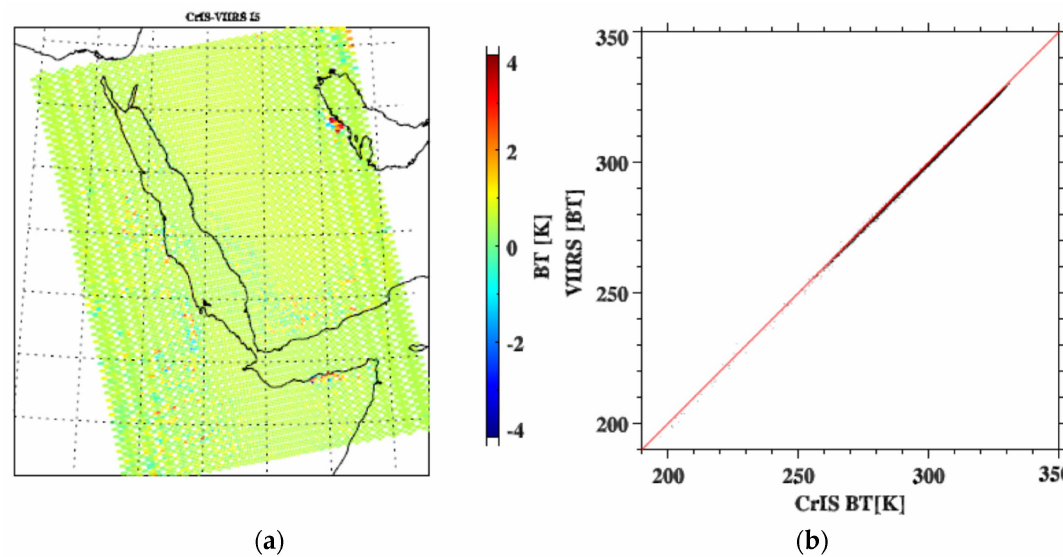
Figure 8. CrIS-VIIRS BT difference image map ( a ) and scatter plot of VIIRS BT versus CrIS BT for VIIRS I5 band ( b ). CrIS spectra are convolved with VIIRS SFRs to simulate VIIRS I5 band radiances, while collocated VIIRS radiances are spatially averaged within CrIS FOVs. The original CrIS and VIIRS images can be found in Figure